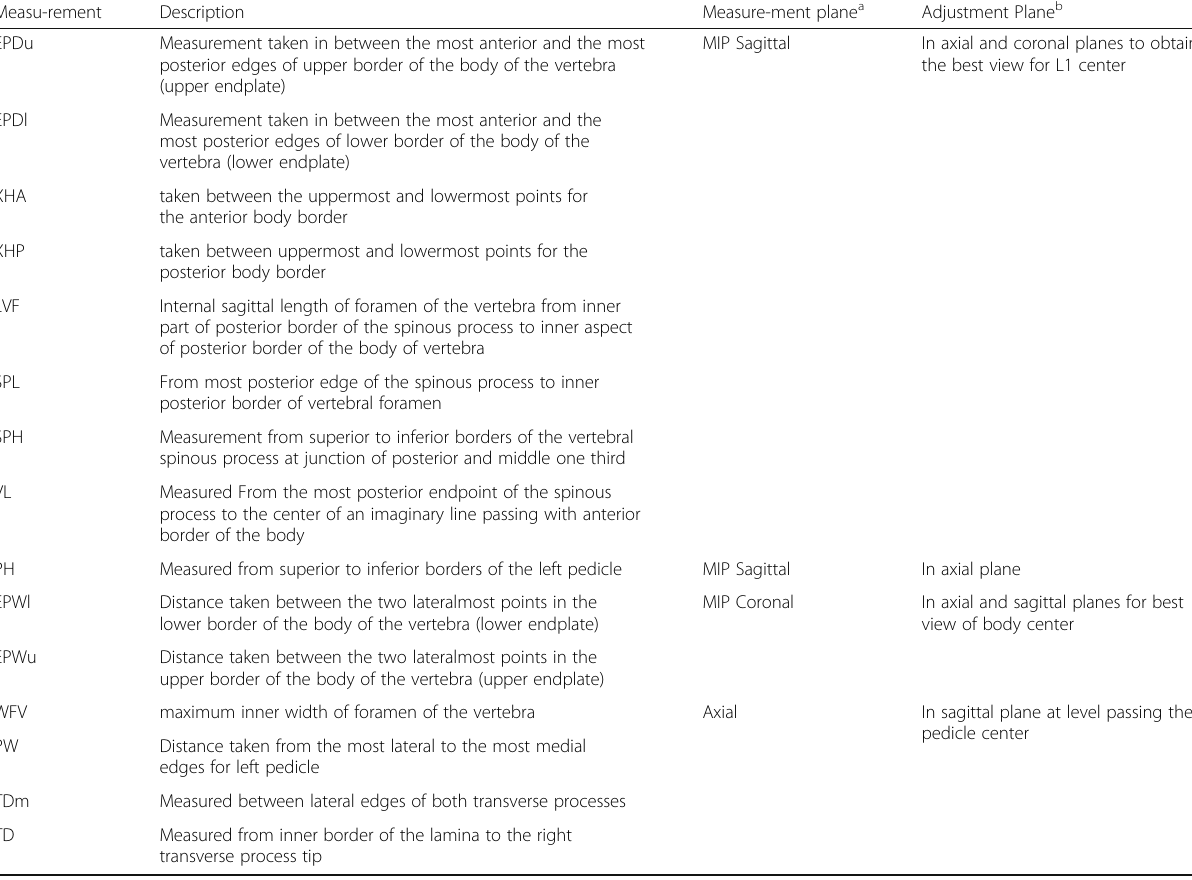
Table 1 Description of Measurements taken from first lumbar vertebra (L1)